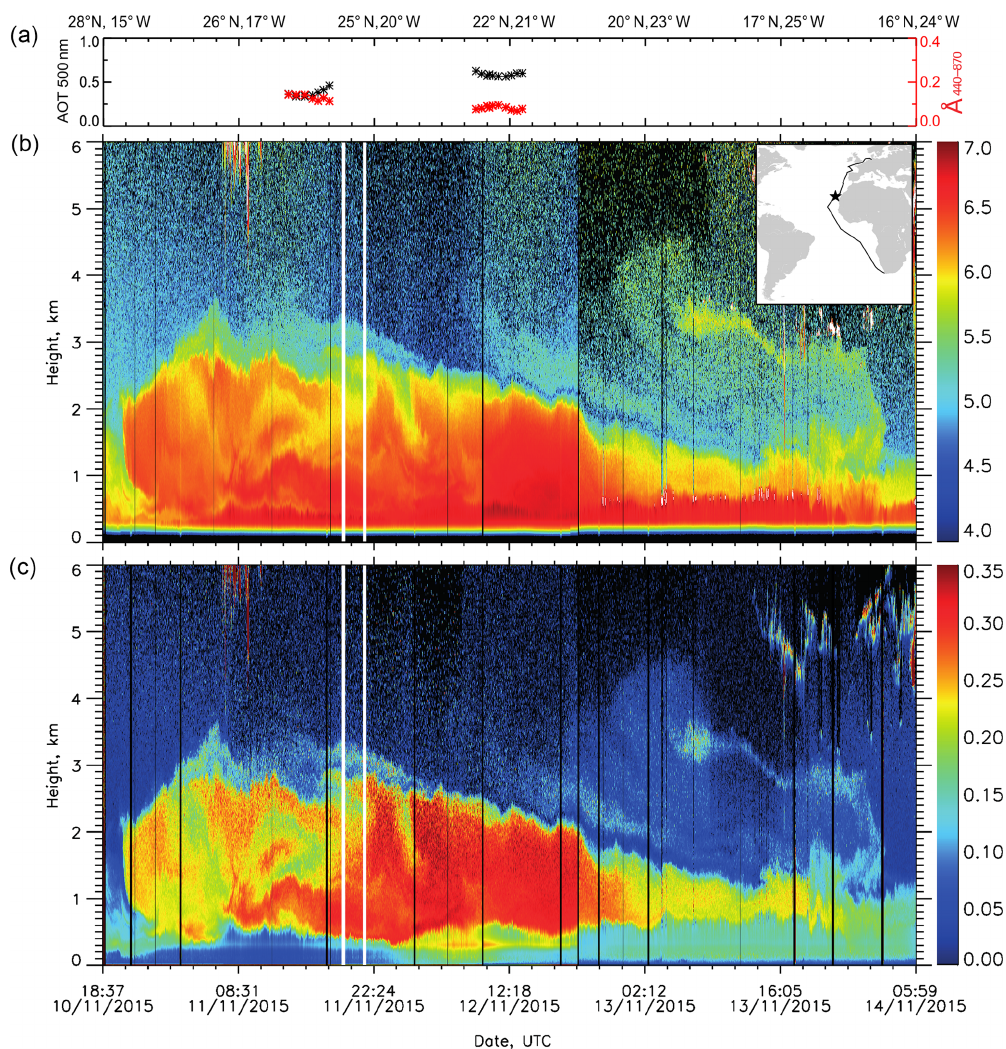
Figure 8. First dust event observed during PS95: time series of the Microtops sun-photometer-derived AOT (500nm) and 440/870nm Ångström exponent (a) , 1064nm range-corrected signal (b) , and 532nm volume depolarisation ratio (c) . Vertical white lines indicate the signal-averaging period for profiles shown in Fig. 9. The black star in the cruise map shows the location of RV Polarstern during this